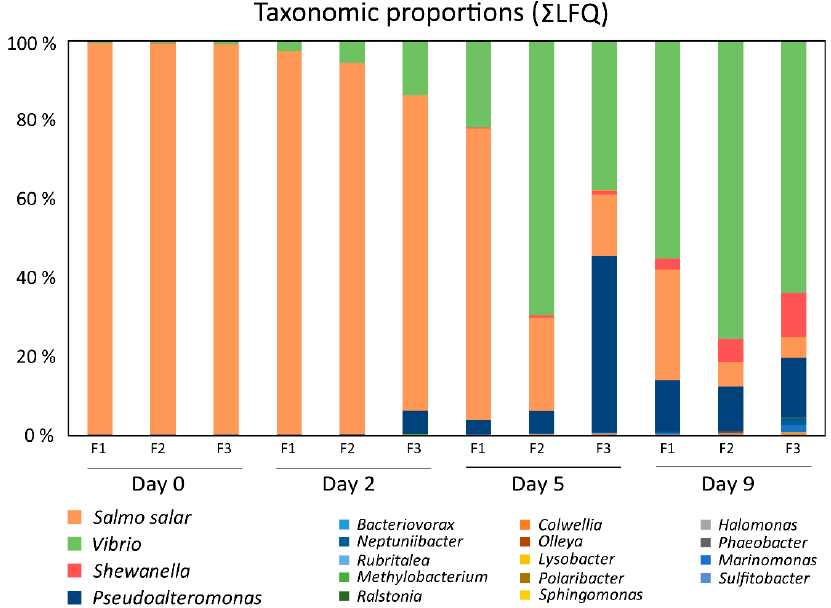
Figure 2. Taxonomic proportions of proteins in mucus over time. The bar chart shows the taxonomic proportions at the genus level, based on expressed proteins, assigned to the bacterial community over 9 days of mucus incubation with sterilized seawater. In addition, the proteins associated with salmon are displayed as “ Salmo salar ”. Table 1. The total number of proteins (all the time points) assigned to the different genera identified by 16S rRNA sequencing (Fig. 1) and the amount of proteins predicted as secreted.